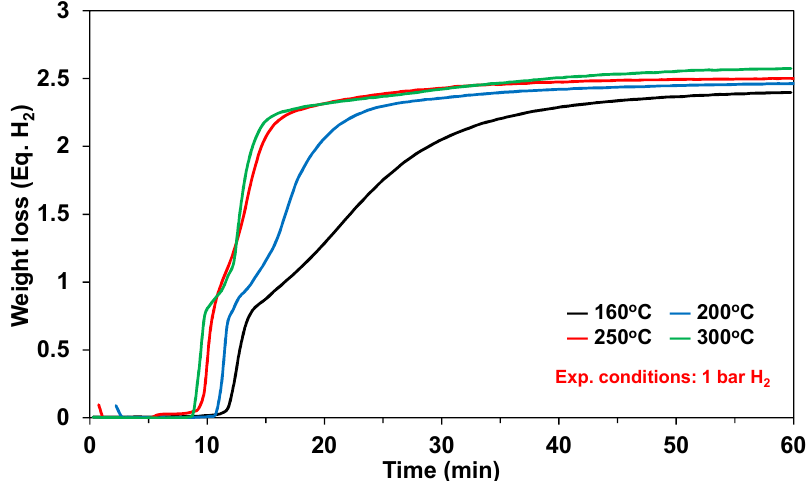
Figure 5. Measurements of hydrogen capacity and bulk kinetics of solid ammonia borane (AB) at 160 °C (black), 200 °C (blue), 250 °C (red), and 300 °C (green). Reproduced from [7].